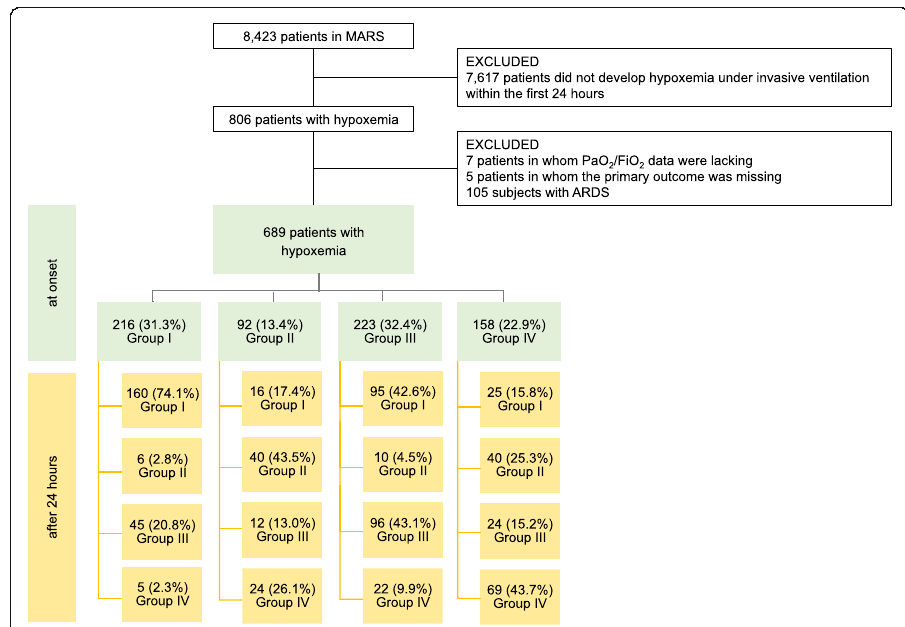
Fig. 1 Patient flow and evolution of patient classification; patients were classified at onset of hypoxemia (green boxes) and after 24 h of standard care (yellow boxes); numbers represent the number of patients per group with the fraction of